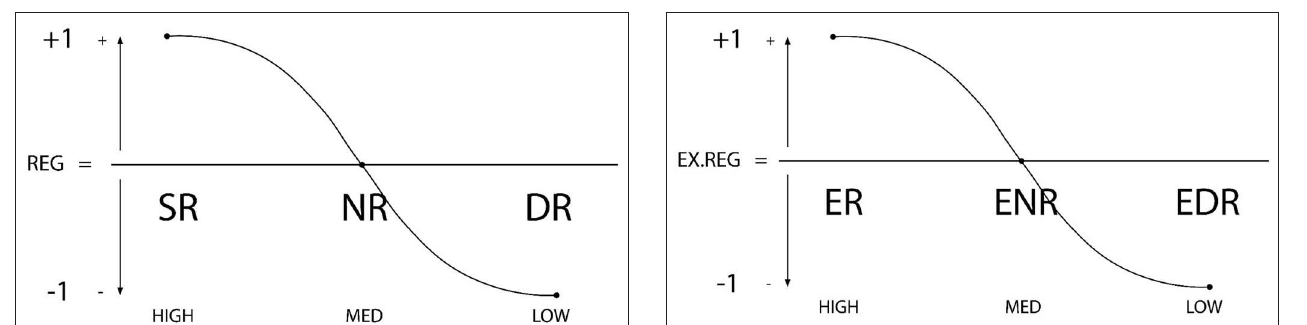
range where the person-context interaction progresses from least favorable to most favorable: from a minimum average of 1 point (1-point personal self-regulation and 1-point external regulation), to a maximum of 3 points (3-point self-regulation and 3-point external regulation). The possible regulation averages can then be ranked in order from 1 to 5, across the regulation range (regulation average of 1 = rank